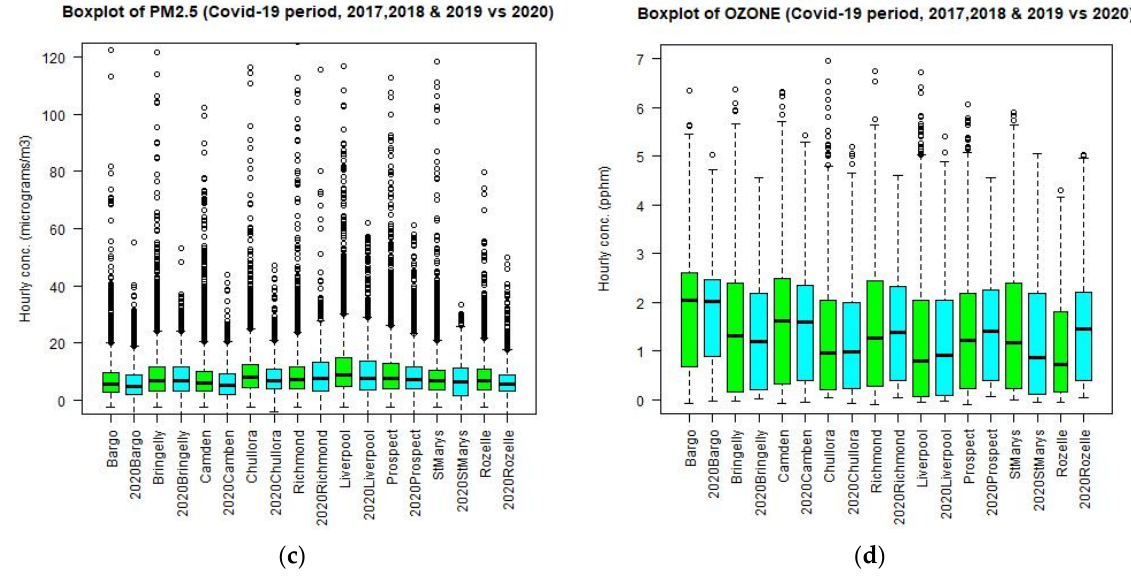
Figure 11. Boxplot of NO 2 ( a ), CO ( b ), PM 2.5 ( c ), and O 3 ( d ) at different sites in the GMR based on pooled 2017, 2018, and 2019 data and those based on 2020 side by side for the period from April to June.